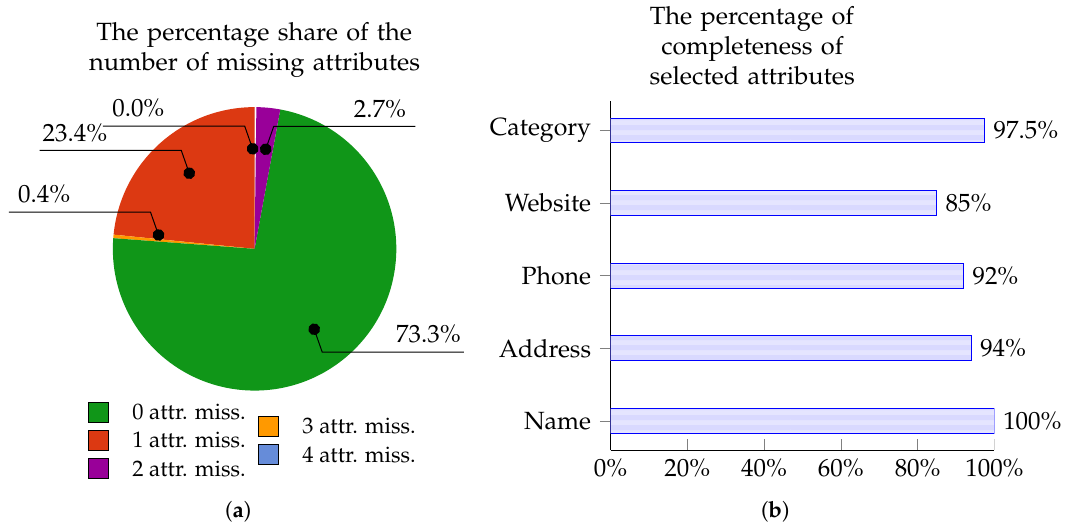
Figure 7. Facebook Places: The percentage of POIs with 0–4 missing attributes ( a ); and the percentage of completeness of selected attributes ( b ).